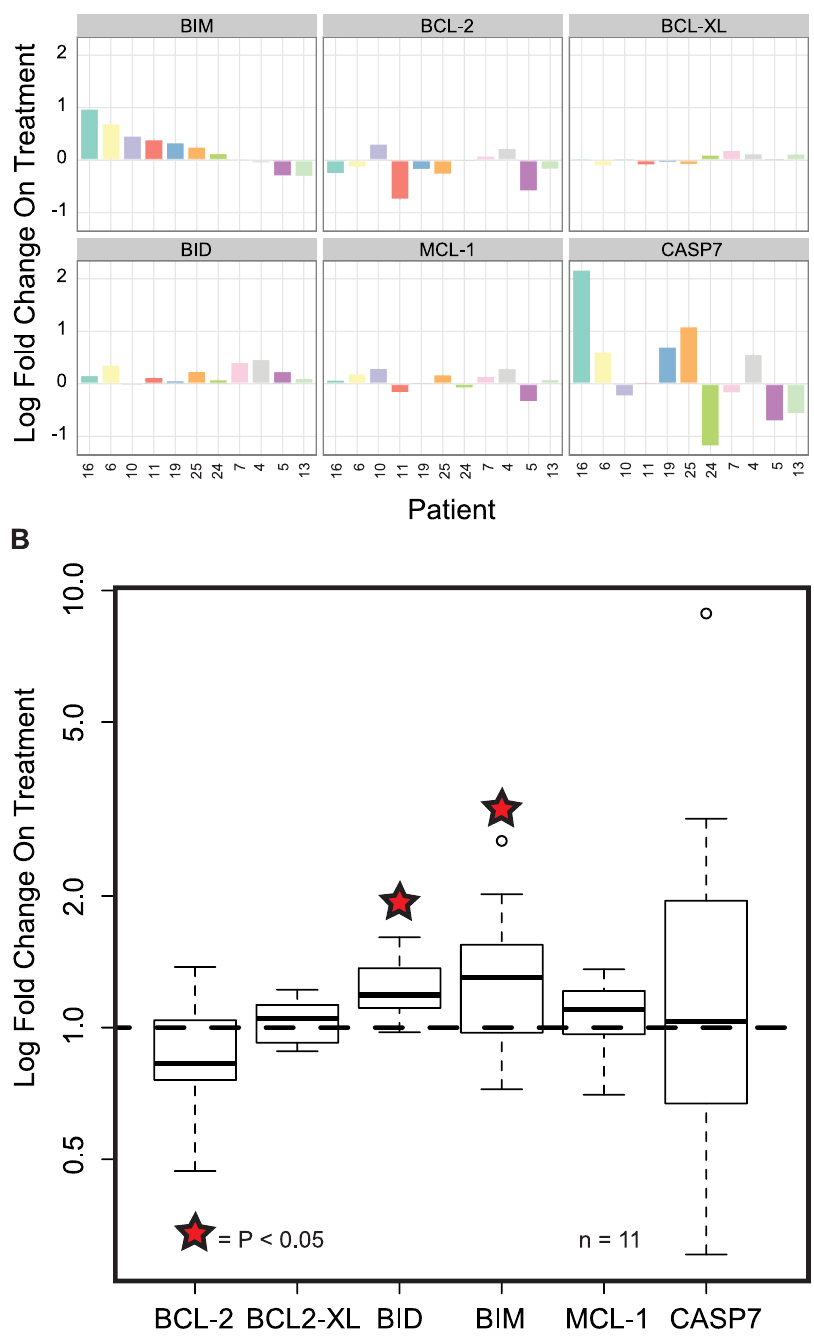
Figure 3. Protein expression levels of BCL2 family members in patients undergoing treatment with a BRAF inhibitor. RPPA analysis of tumors from patients with metastatic melanoma shows a significant increase of BID and BIM on BRAFi. ( A ) Protein expression levels of each gene from pre and on treatment biopsies for each patient are shown as log fold change on treatment. ( B ) Changes in protein expression levels across patients 10–14 days after initiation of BRAFi are plotted on a log scale as fold change from pre-treatment levels using box and whisker plots (*=P # 0.05). doi:10.1371/journal.pone.0101286.g003 in 3% H 2 O 2 , HRP- labeled anti-rabbit secondary antibody (Dako Apoptosis in Xenografts EnVision, K4003, RTU) was applied for 30 minutes. Slides were Tumors were fixed in 10% neutral buffered formalin, embed- developed with DAB + (Dako K3468) and counterstained with ded in paraffin, and sectioned at five microns 3 days after hematoxylin (Vector H-3401) prior to dehydration and mounting. treatment commenced. Deparaffinized and rehydrated sections